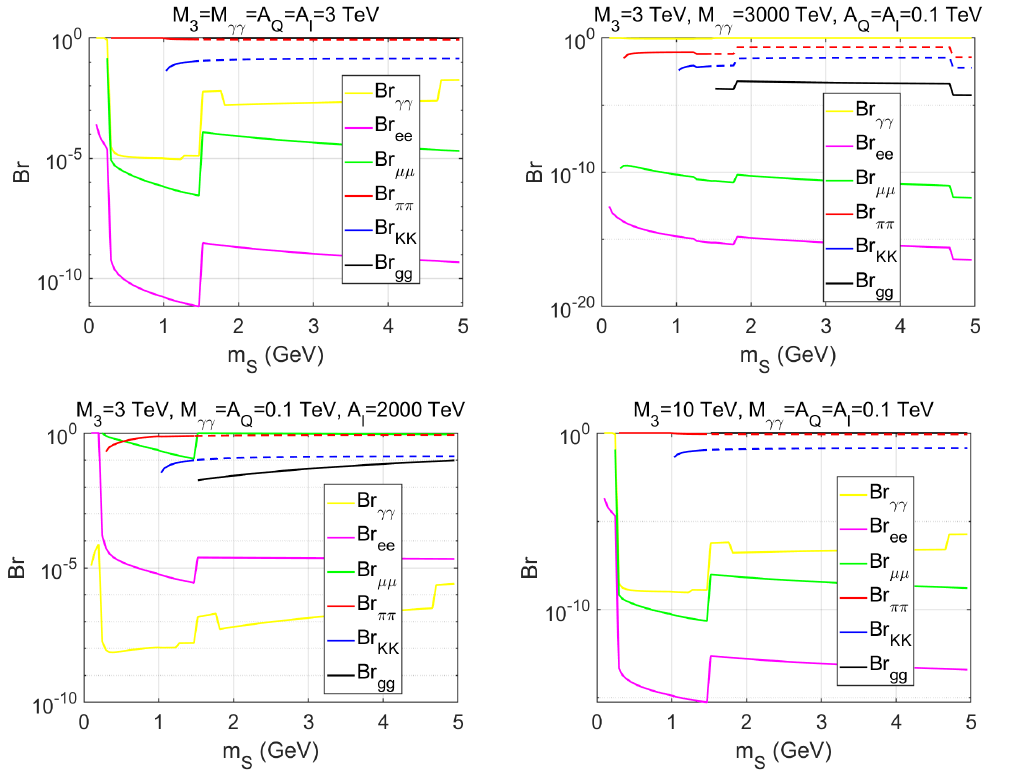
Figure 2 . Scalar sgoldstino decay branchings for channels S → ee, µµ, γγ, ππ, KK for chosen sets of supersymmetry breaking soft terms. For m S > 1 . 5 GeV we use decays into gluons for all hadronic decay modes.